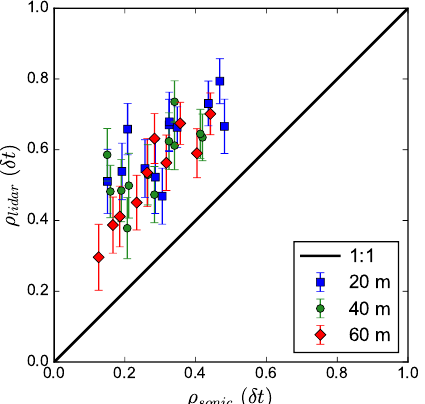
Figure 7. Comparison of the values of radial velocity autocorrela- tion function from sonic data ( ρ sonic ) and lidar data ( ρ lidar ) at the first time lag δt = 7 . 5s. The 95% confidence interval of ρ lidar is indicated by the error bar.